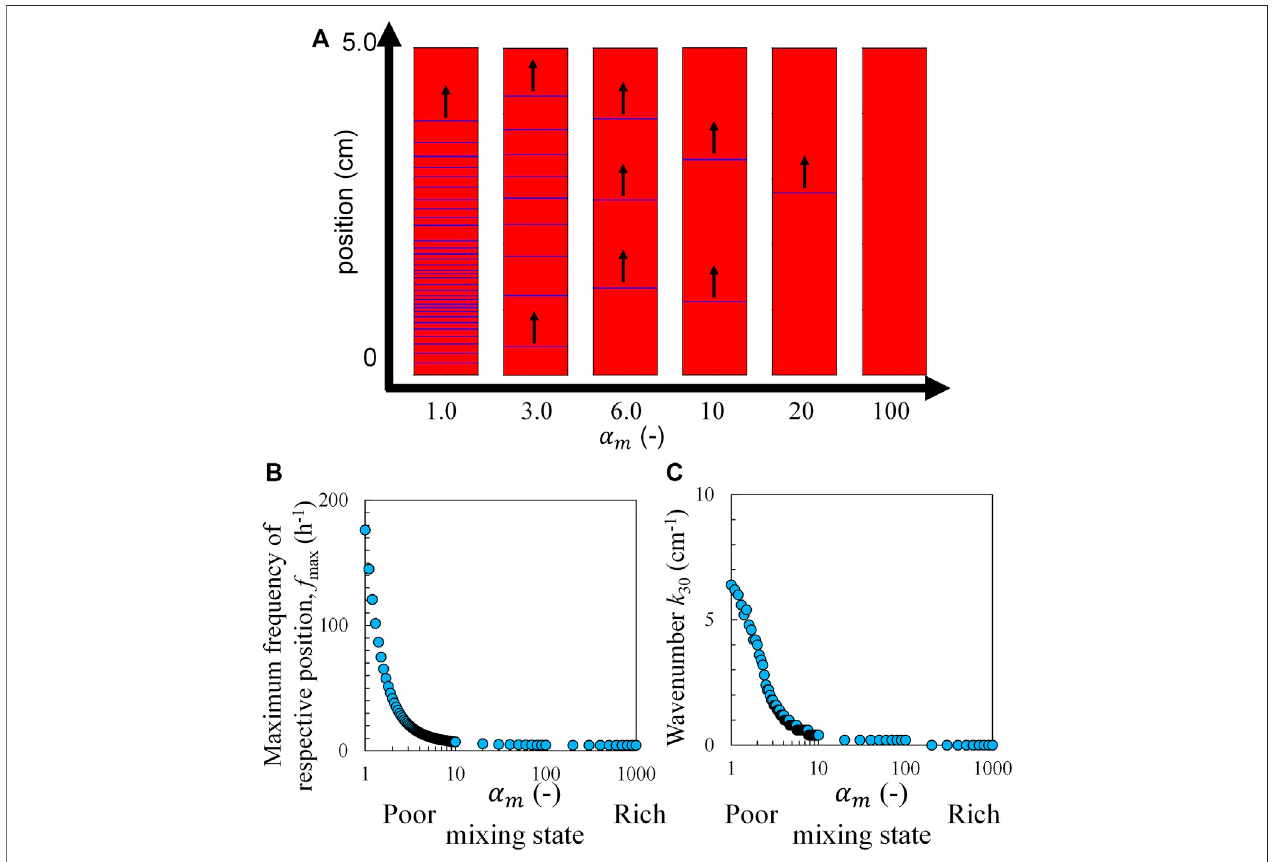
FIGURE 6 | Calculation results based on the RZ model and the concentration distribution with Eq. 6 , (A) the pseudo-colored image of the chemical wave, (B) maximum frequency, and (C) wavenumber as a function of s 30 min after mixing. The black arrows indicate the travel direction.